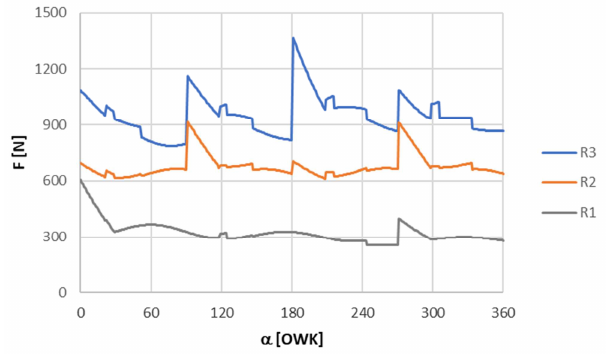
Fig. 13. The reaction values in camshaft bearings as a function of the rotational angle for its average rotational speed of 750 rpm and belt tension of 200